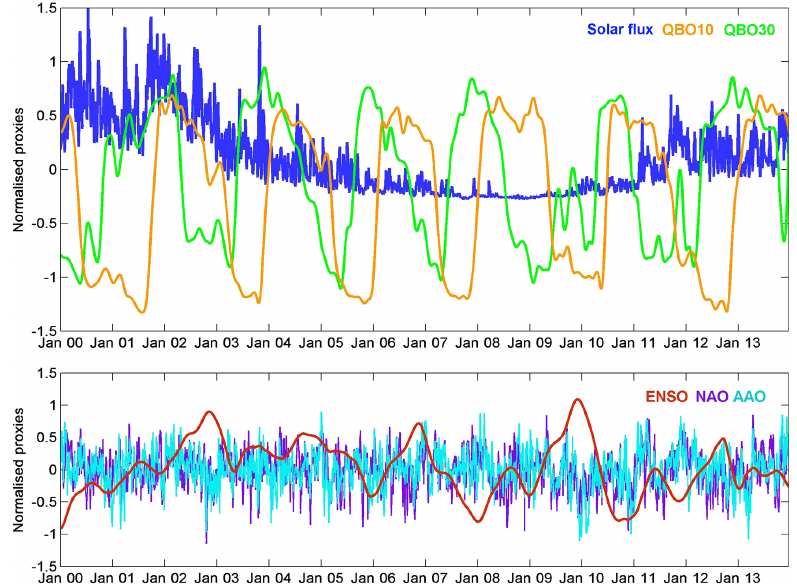
Figure 3. Normalised proxies as a function of time for the period 2000–2013 for the solar F 10 . 7 cm radio flux (blue) and the equatorial winds at 10 (green) and 30hPa (orange), respectively (top panel), and for the El Niño (red), North Atlantic Oscillation (purple) and Antarctic Oscillation (light blue) indexes (bottom